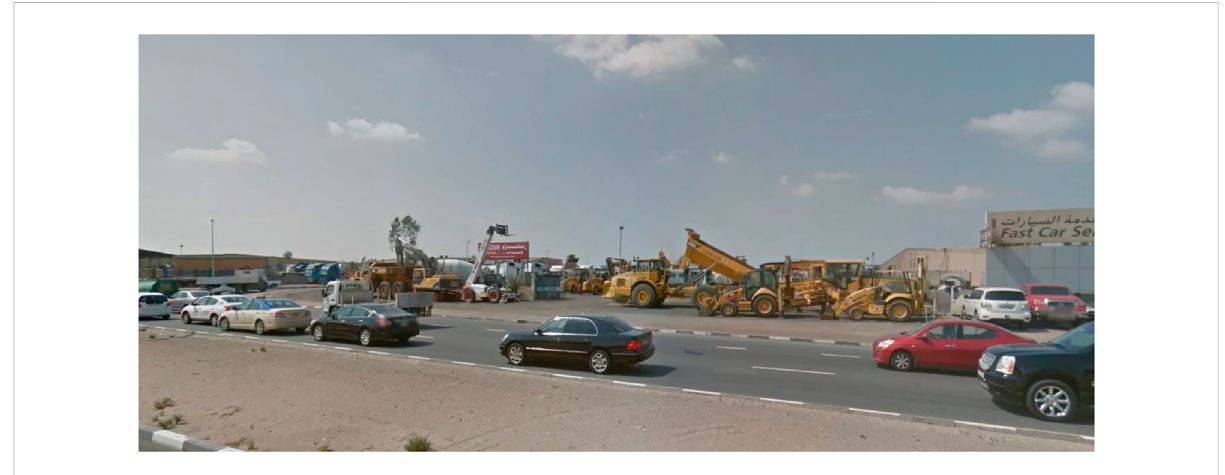
FIGURE 5 Urban context of wasl green park at ras Al khor industrial